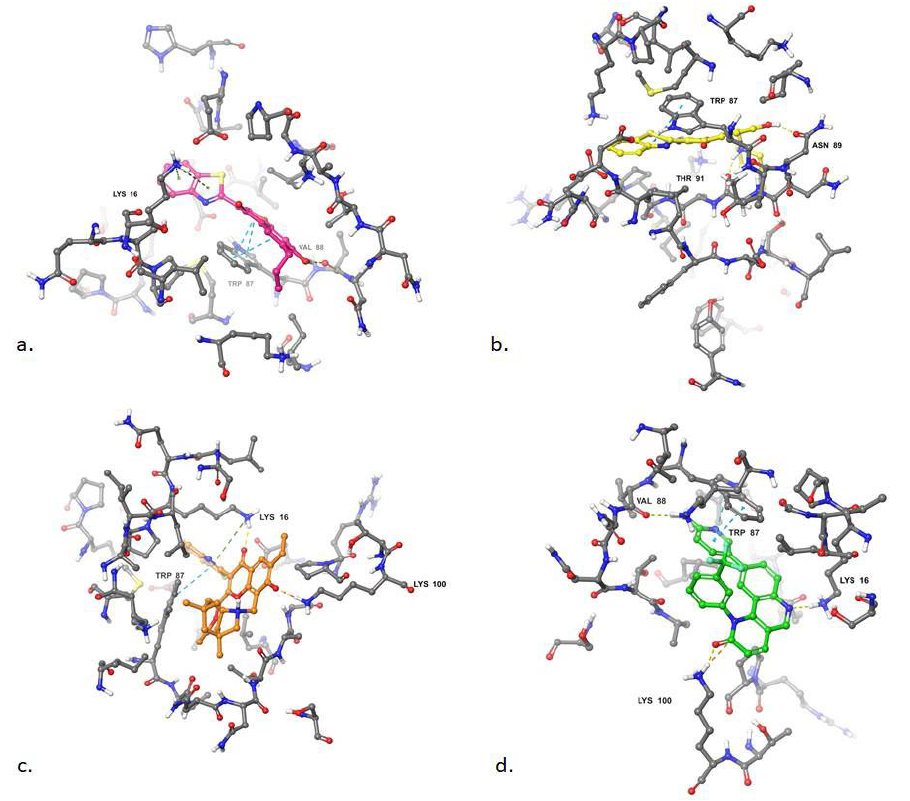
Figure 10. Binding pose for the compounds ( a ) 2c, ( b ) 7h, ( c ) 7l and ( d ) Torin2 at the binding site.